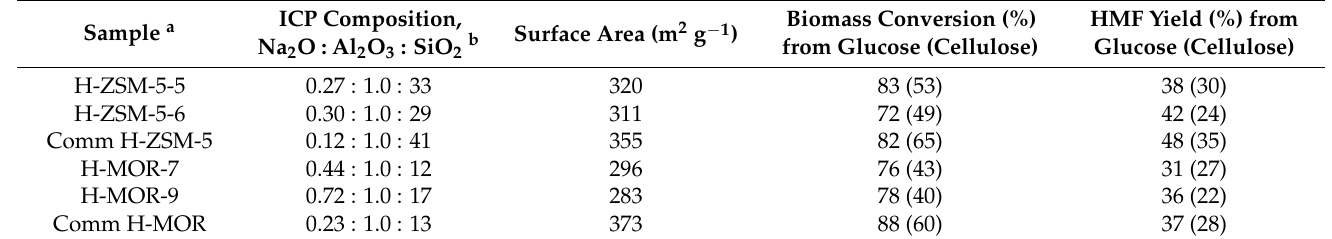
Table 4. Comparison of relative composition and surface area for acid-exchanged single-phase zeolite samples and commercial ZSM-5 and mordenite materials. (Reprinted from [44]. Published by The Royal Society of Chemistry).